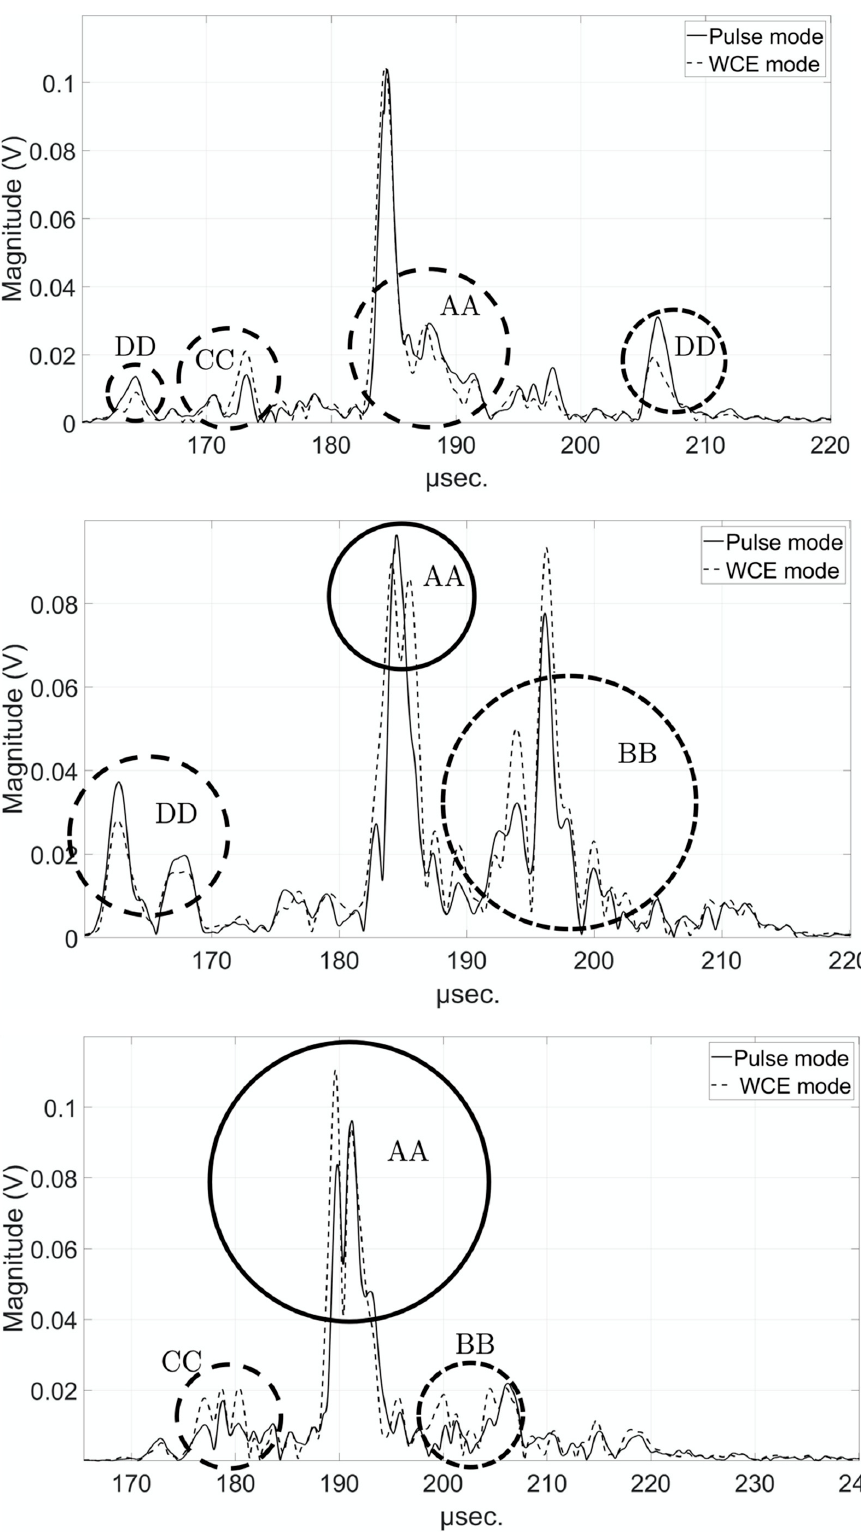
Figure 15. Detailed examples of the signals (envelope) at 1 MHz for the chicken drumstick in pulse-mode (solid line) and in WCE-mode (dotted line) for the angles 5 ◦ (top), 90 ◦ (middle), and 336 ◦ (bottom). AA: increase in resolution; BB: increase in amplitude and resolution; CC: increase in amplitude; DD: decrease in